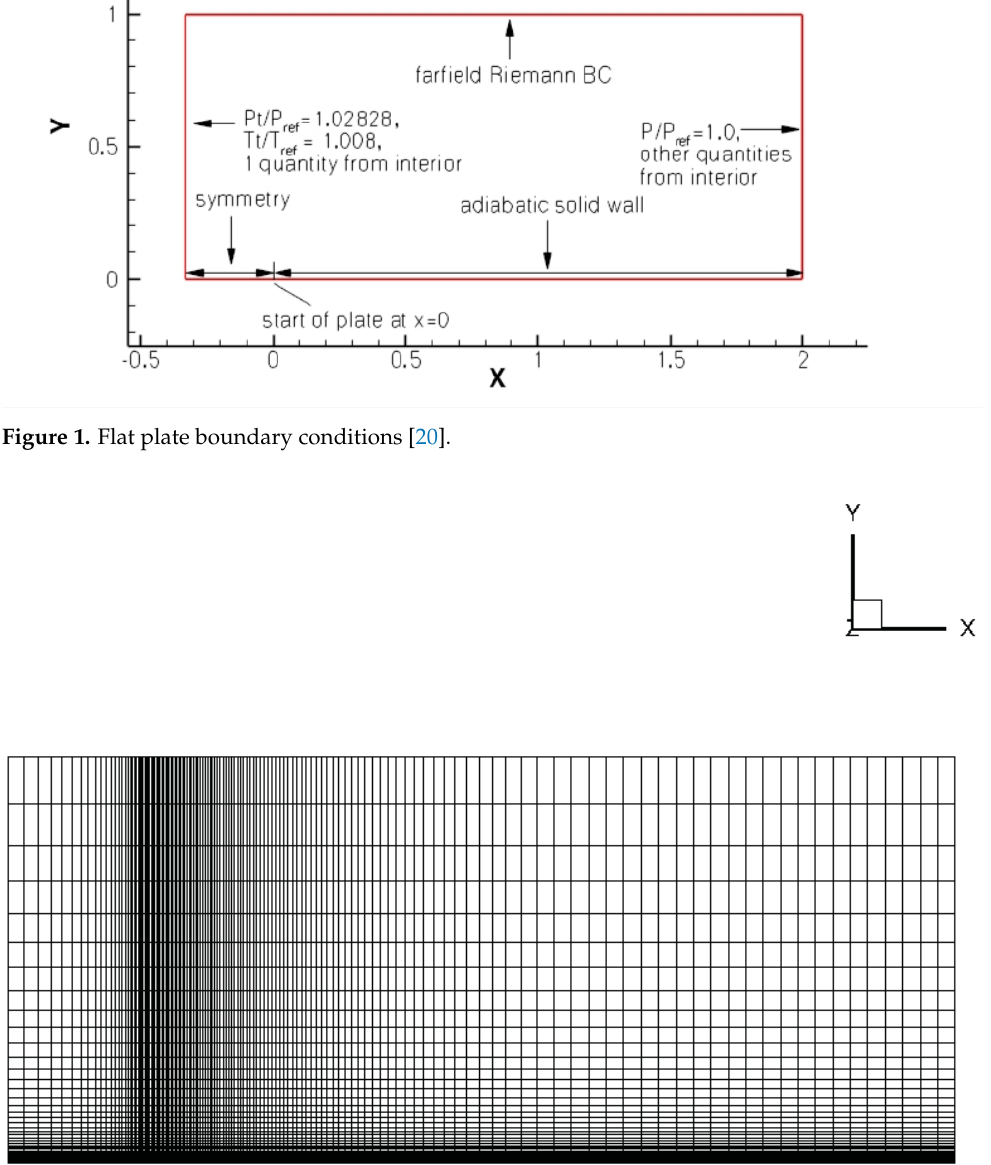
Figure 2. Flat plate coarse